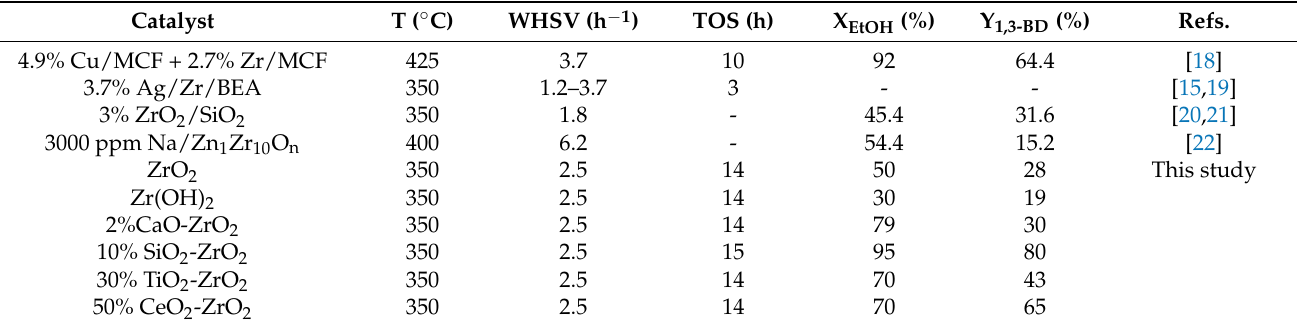
Table 1. Zr-containing catalyst for 1,3-butadiene production from